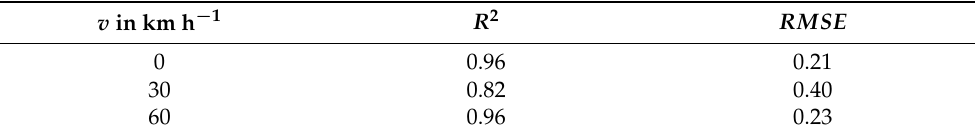
Table 1. Goodness-of-fit parameters for the logarithmic fit function at the three velocities ( R 2 : Coeffi- cient of determination, RMSE : Root mean squared error). The determined parameters confirm the logarithmic relationship between the roadway luminance and the medians of the brightness rating.